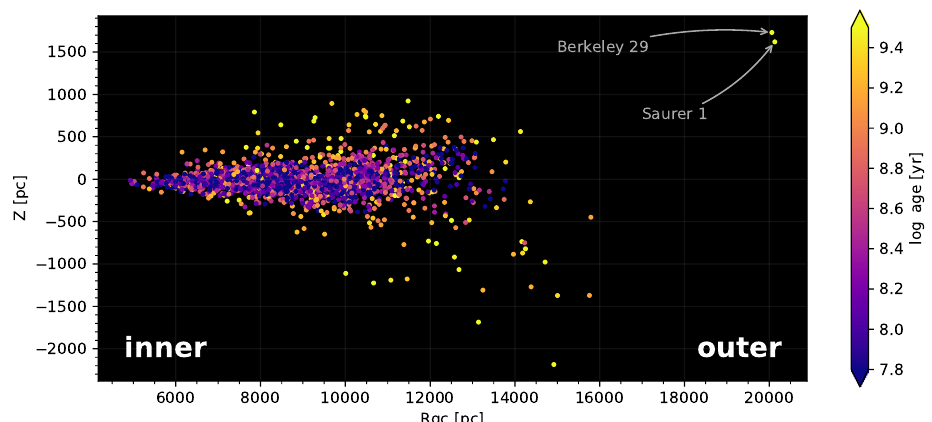
Figure 4. Distance above the Galactic plane ( Z ) against Galactocentric radius (Rgc) for all 2531 clusters with ages from Cantat-Gaudin et al. [72] and Castro-Ginard et al. [73], colour-coded by age. The change of scale height between the inner and outer disc is clearly visible. The two distant clusters Berkeley 29 and Saurer 1 are